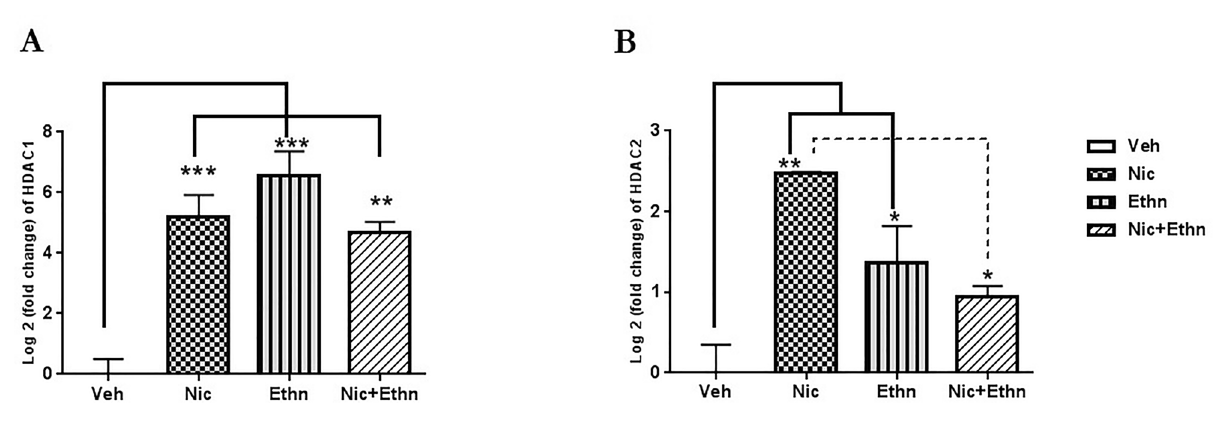
Figure 5. The effect of maternal exposure to nicotine and ethanol, alone and concurrently, on the expression level of enzymes involved in histone deacetylation. Real-time quantitative PCR (RT-qPCR) analysis of histone deacetyltransferase (HDAC) 1 and 2 gene expression in sperm cells of F1 sperm cells from vehicle and exposed animals. Graphs present mean ± SEM. Data from each gene were normalized to the corresponding value of the housekeeping gene (Actb). Data are exhibited as log twofold changes of relative expression levels of each group compared to the vehicle. *, ** and *** indicate p ≤ 0.05, p ≤ 0.01 and p ≤ 0.